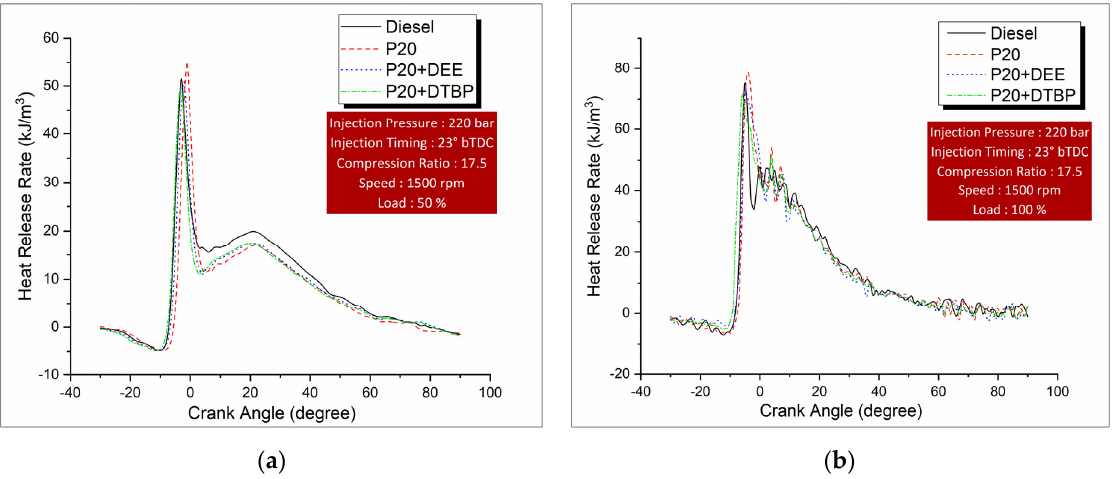
Figure 3. HRR variation for test fuel blends, ( a ) at 50% load; ( b ) at 100% load.